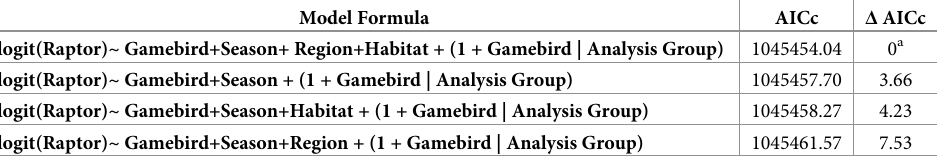
Models with Δ AICc (difference in AIC points from top model) less than or equal to 10 are shown above. a We used this model in the